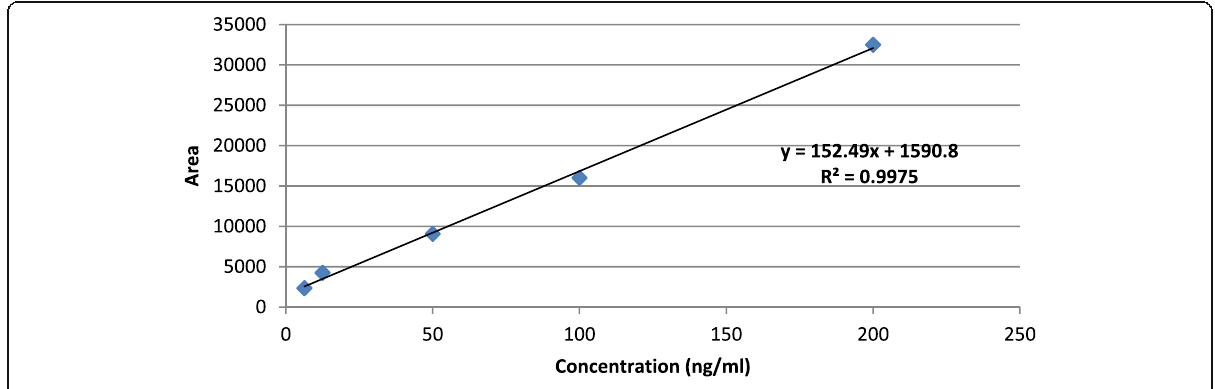
Fig. 7 Calibration plot of naringenin in rat plasma